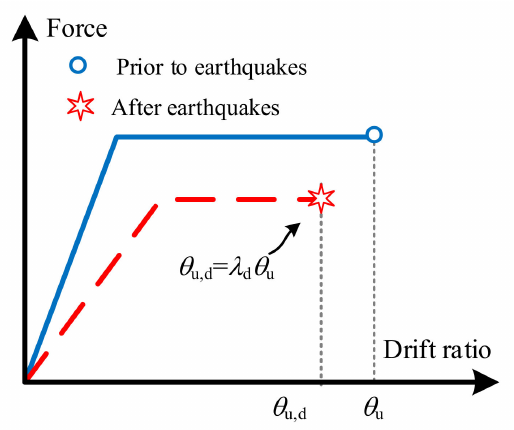
Figure 4. The collapse point of the RC